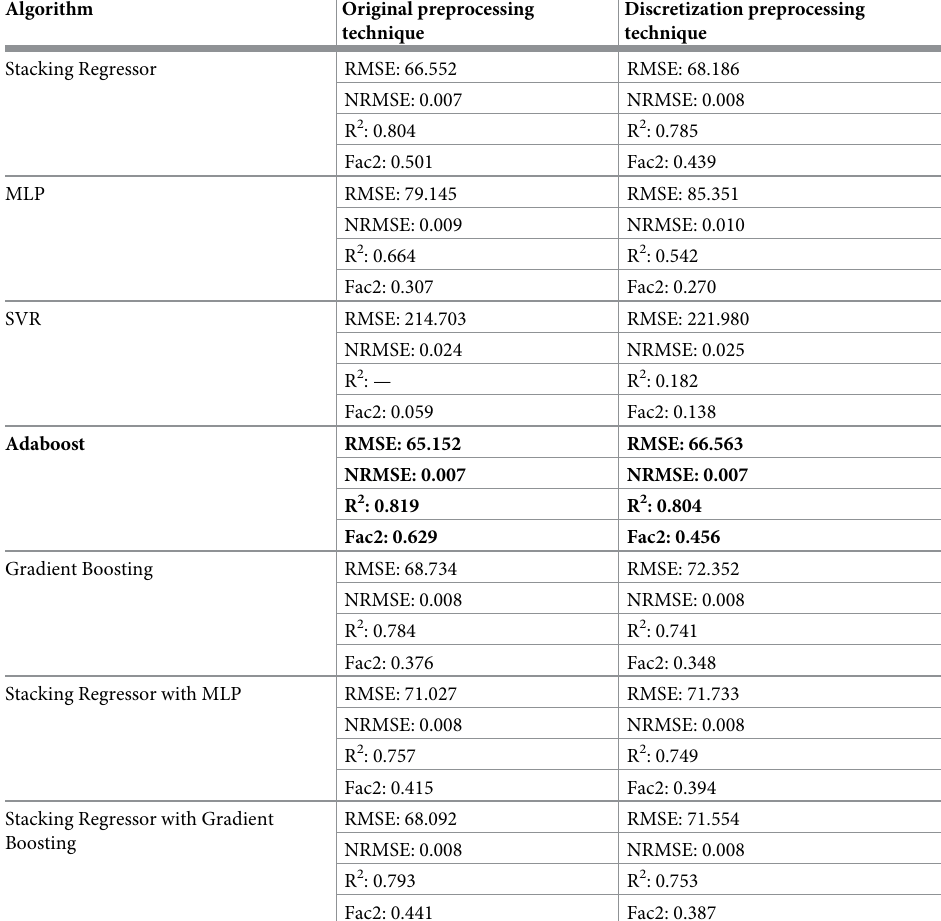
Table 8. Metrics of all algorithms for all preprocessing techniques using test dataset.